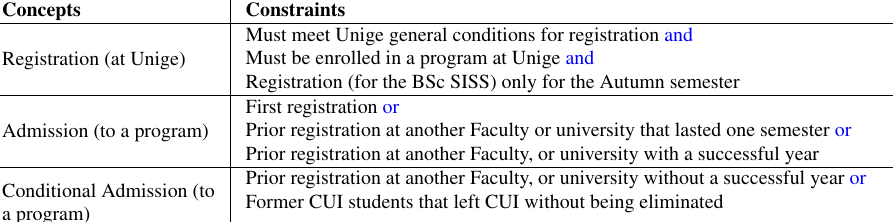
Table 2: Concepts and Constraints of Study Regulation of the BSc SISS